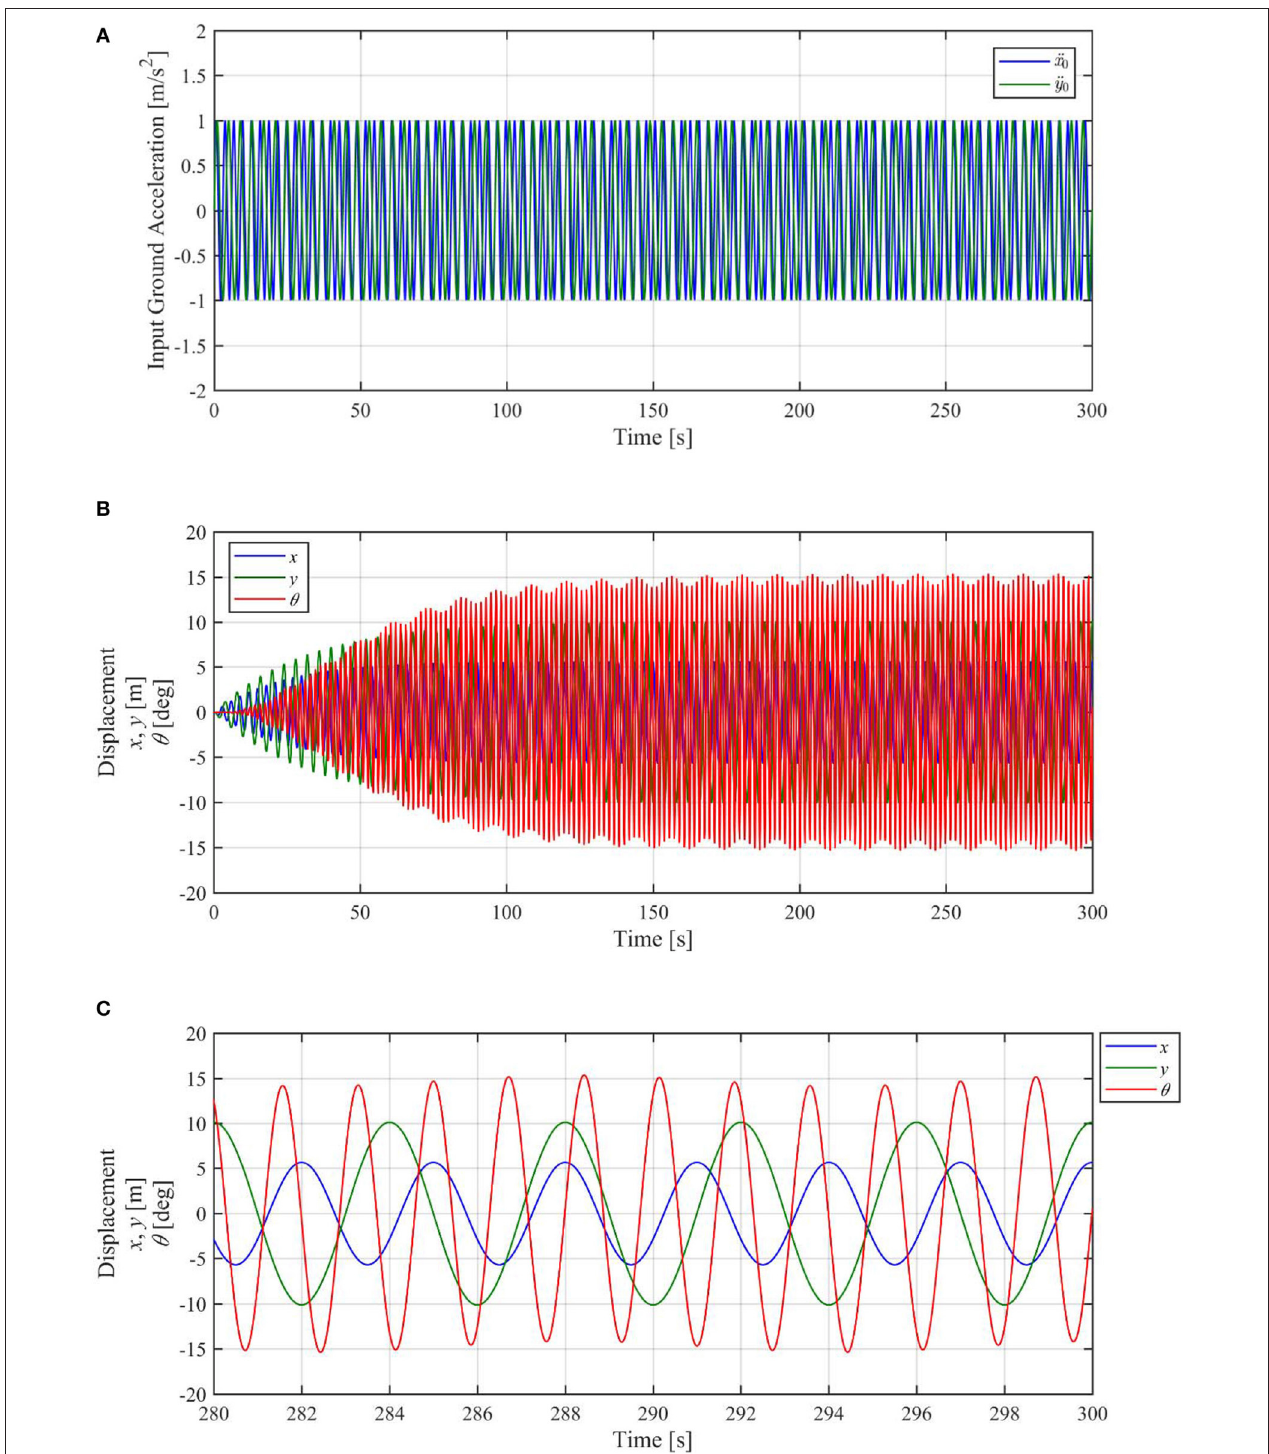
FIGURE 5 | Time-history analysis result of displacement response to sinusoidal ground acceleration. (A) Input ground motion, (B) Displacement response, (C) Displacement response (zoomed-up graph).